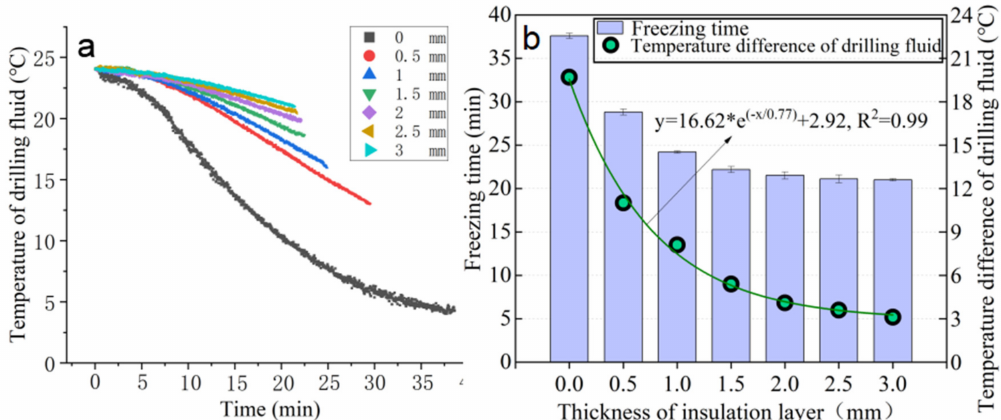
Figure 7. ( a ) Relationship between drilling fluid temperature and time. ( b ) Relationship between temperature difference of drilling fluid before and after freezing, freezing time and thickness of the insulation